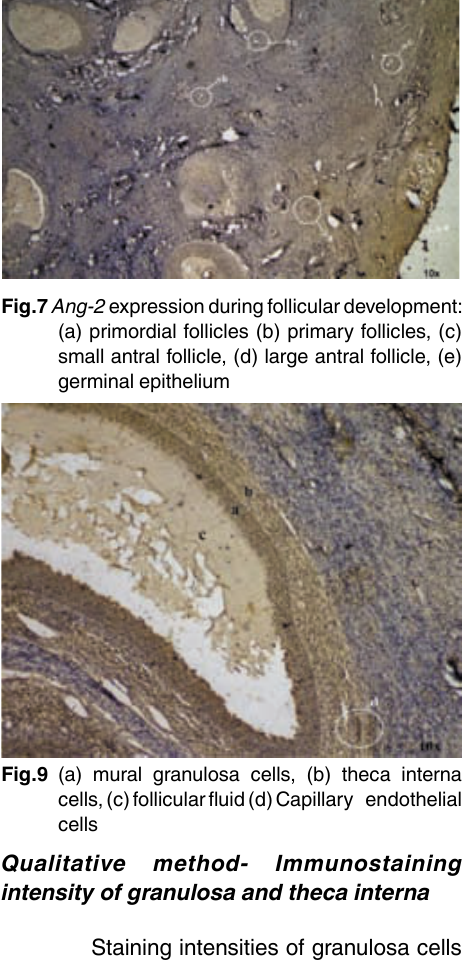
table 1. Percentage of positivity of Ang-2 expressions during follicular development Follicles